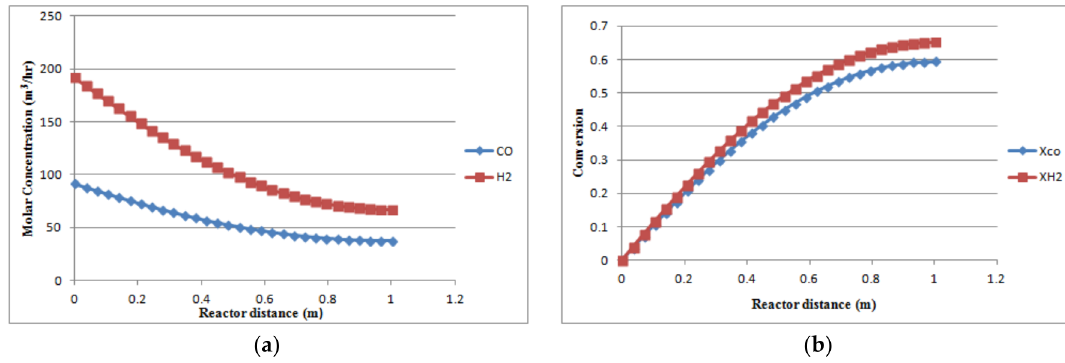
Figure 12. The syngas variation on the reactor inside, ( a ) Molar concentration of CO and H 2 ; ( b ) CO and H 2 conversion.